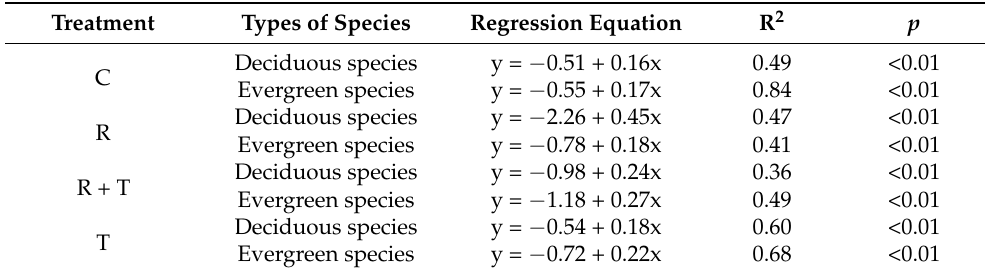
Figure 2. Relationships between the seedling relative growth rate and photosynthetically active radiation under different treatments. Table 2. Linear regression equation parameters for the seedling relative growth rate and photosyn- thetically active